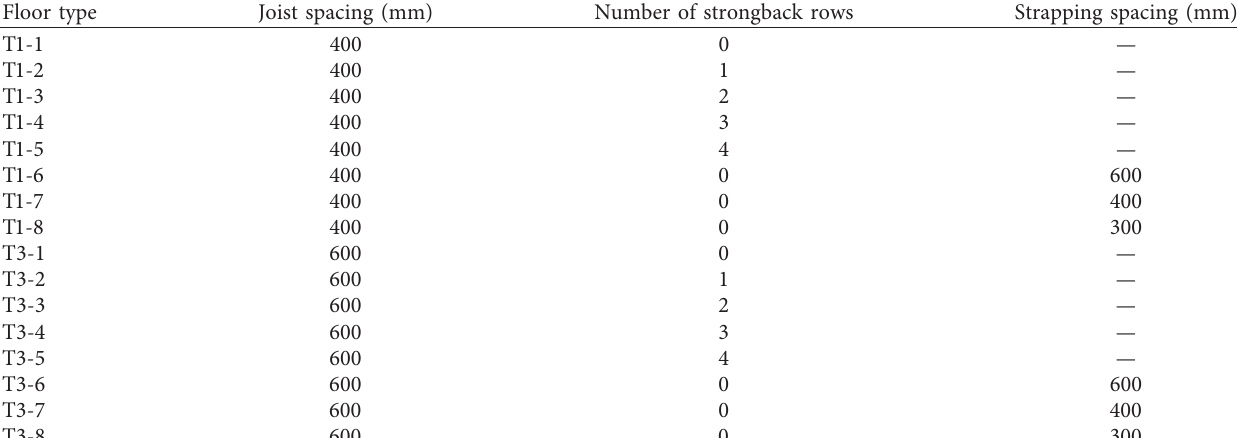
Table 2: Configuration details of the base test floors.